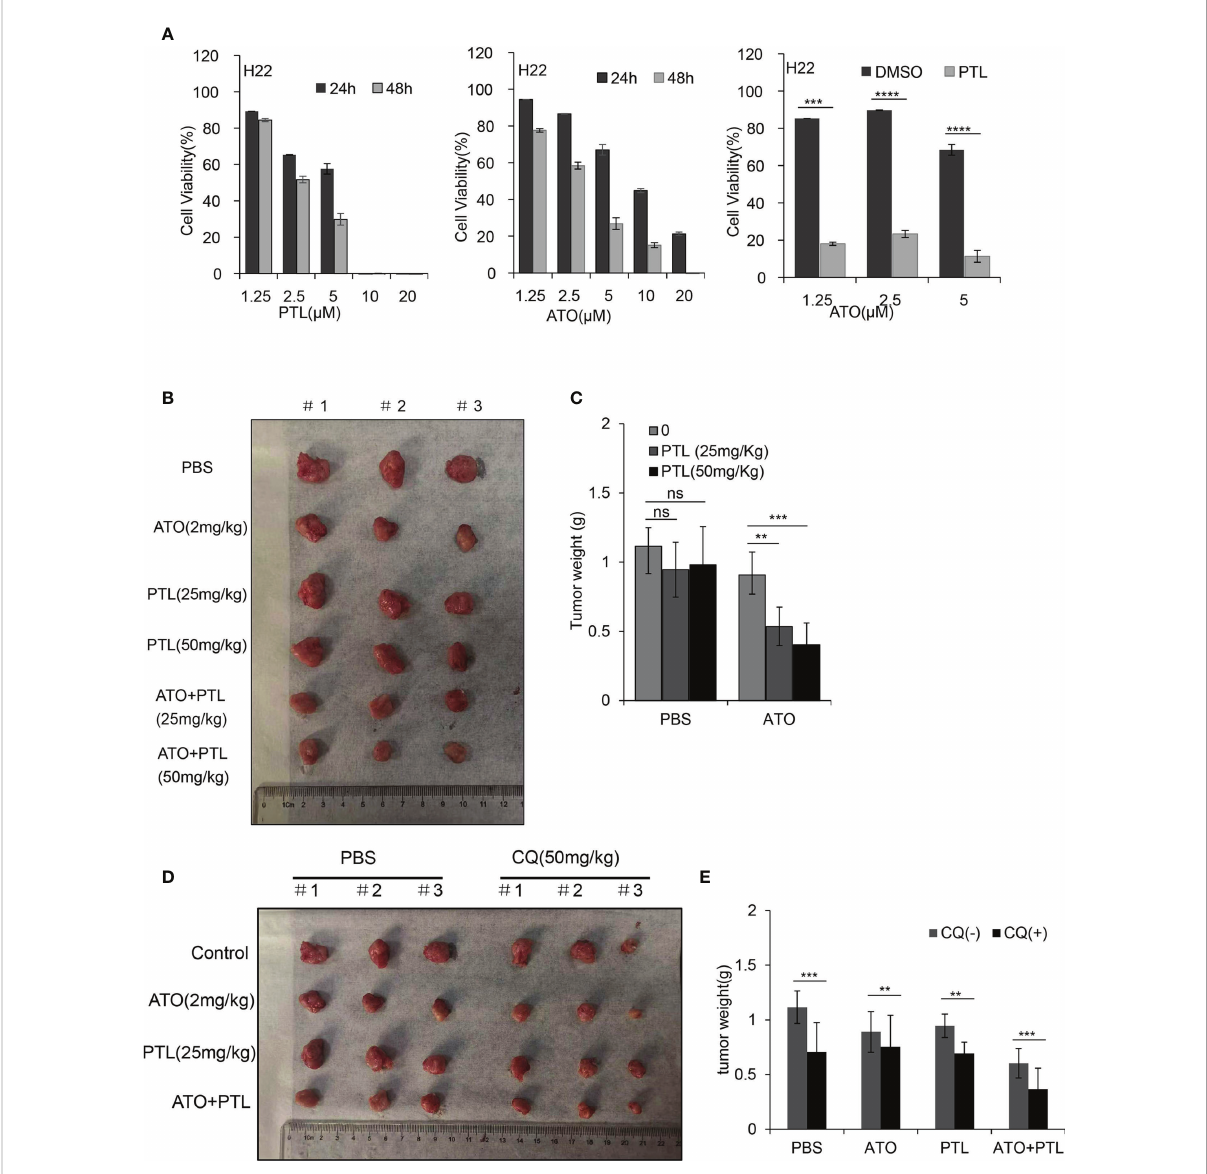
FIGURE 7 Effects of the combination of ATO with PTL on hepatoma growth. (A) MTT assay showing the viability of H22 cells after exposure to increasing concentrations of ATO or PTL for 24 h and 48 h ( P < 0.0001 vs. Control). After exposure to indicated concentrations of ATO, PTL and ATO plus PTL for 24 h, the cell viability was tested by MTT assay. Columns, mean; bars, ± S.D. (*** P < 0.001; **** P < 0.0001). (B, D) Photographs of harvested xenograft tumors prior to processing. (C, E) The weight of xenograft tumors in mice are shown. Columns, mean; bars, ± S.D.(n=3) (** P < 0.01; *** P <